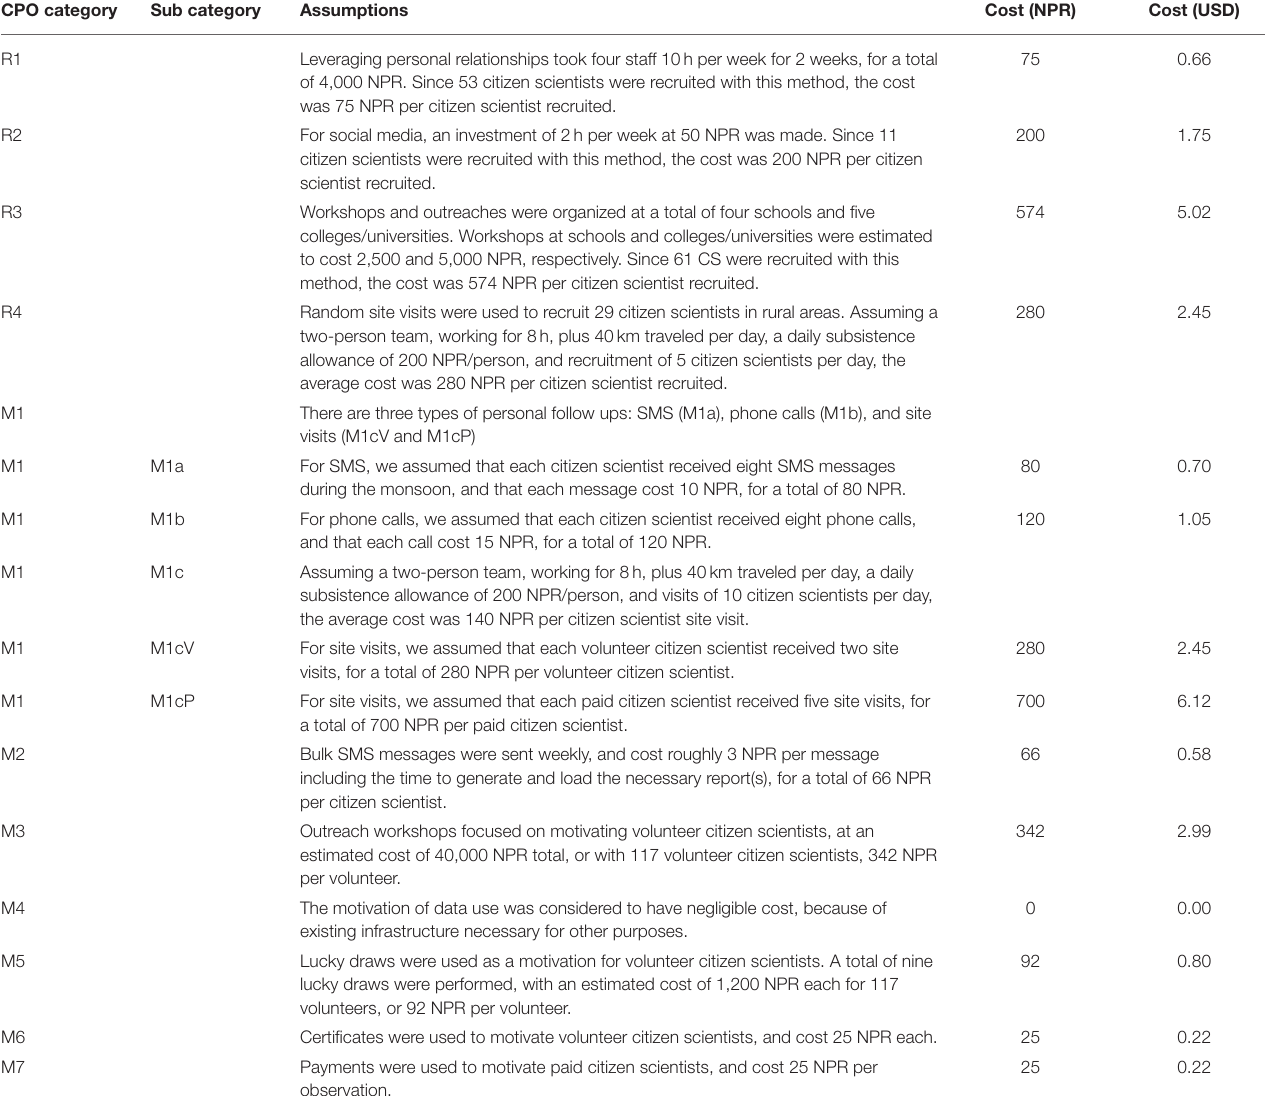
TABLE 3 | Assumptions and the resulting costs for each recruitment and motivational category. CPO